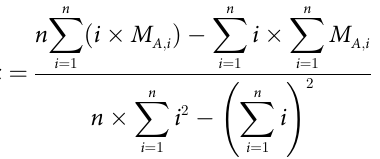
(Table 1). Kriging’s approach for spatial interpolation was applied to process the meteorologi- cal data from 52 meteorological stations in the study area and surrounding regions, and mean values were used to process MODIS data MODI13Q1 from the United States Geological Sur-